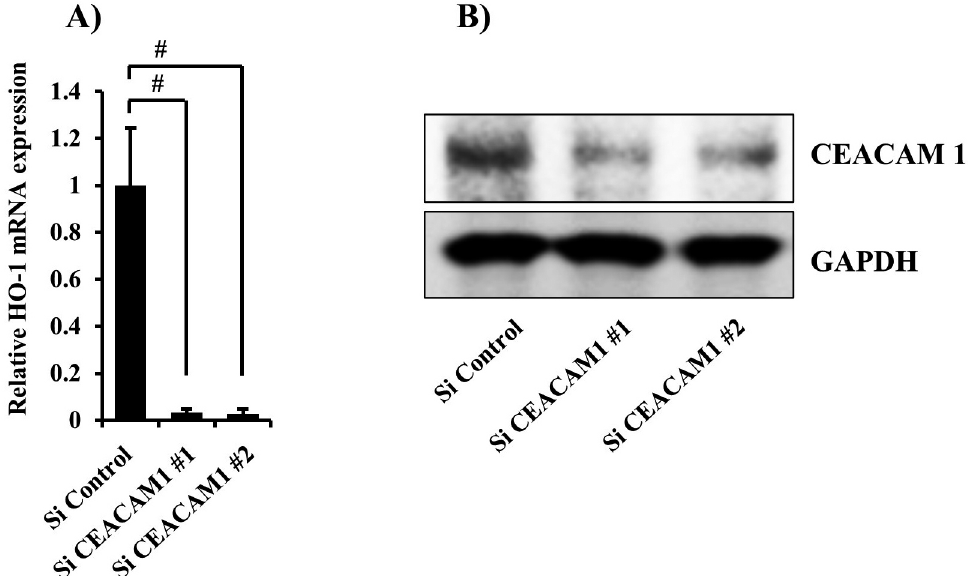
Figure 5- Knockdown of CEACAM1 expression by siRNA (A) Cells were transfected with CEACAM1 siRNA for 48 hours. Gene mRNA levels are presented relative to that of β-actin. Values are shown as fold increase as compared with non-treated cells and presented as the mean±SD of three independent experiments. #Significantly different from Si control-transfected cells (Bonferroni/Dunn's multiple comparison test: p<0.05). (B) Cells were transfected with CEACAM1 siRNA for 48 hours, after which cell extracts were subjected to SDS-PAGE. Western blotting analysis with antibodies against anti-CEACAM1 and GAPDH was performed. The experiments were performed at least three times, with representative results